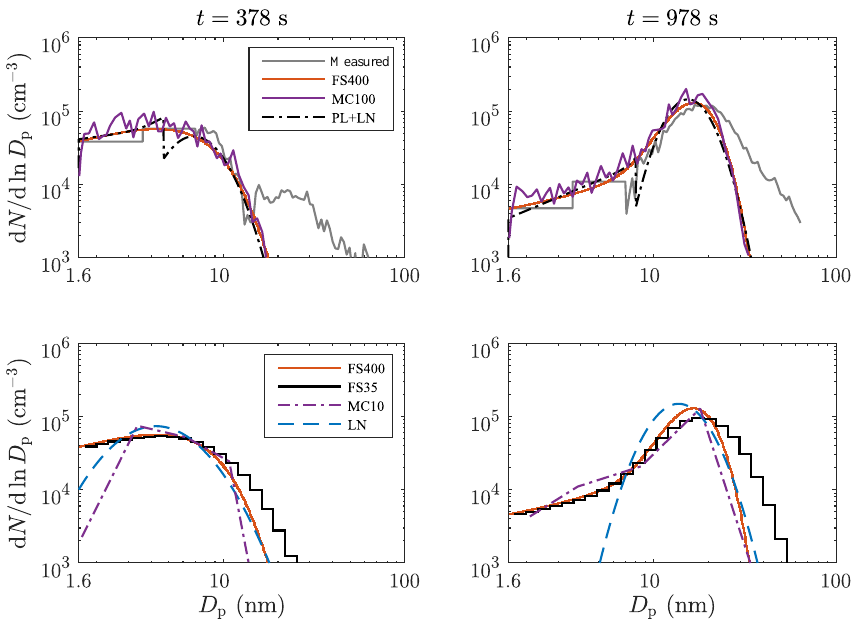
Figure 12. Particle size distributions in the chamber event 378 and 978s after the UV lights were switched on. The top row shows the accurate model outputs together with the measured distribution. The bottom row shows the less accurate model outputs together with the accurate FS400 model output. The measured distributions include also the background distributions around 30 and 50nm which were excluded from the simulations. The abbreviations are explained in Table 3.